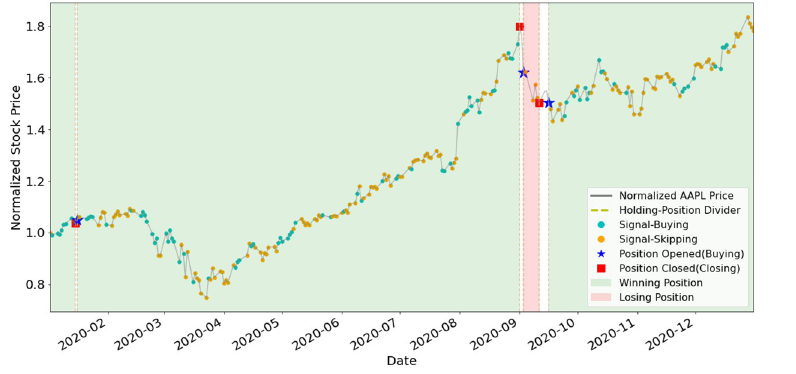
Fig 11. Signals and position-holding of AAPL’s EAM.